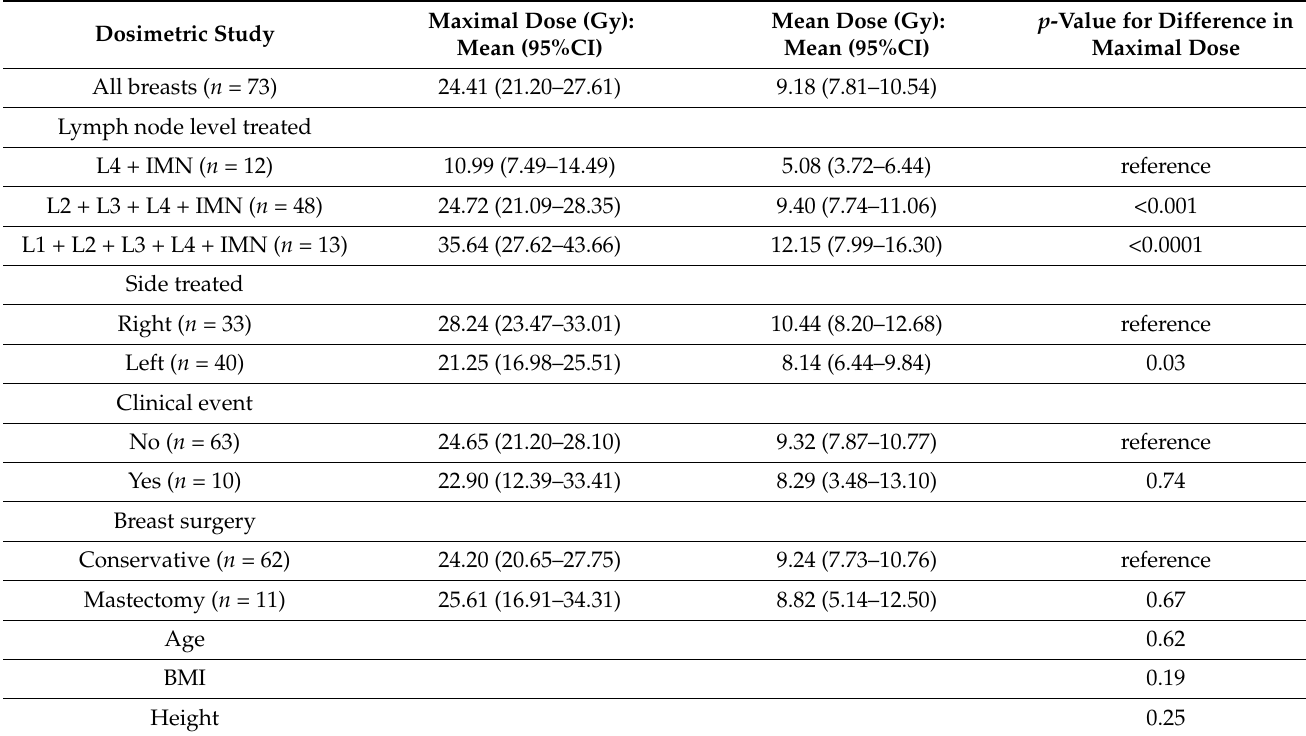
Table 1. Factors significantly associated with the maximal dose received by the ipsilateral humeral head and description of maximal and mean doses in different subgroups. Gy: gray; CI: confidence interval; n : number of